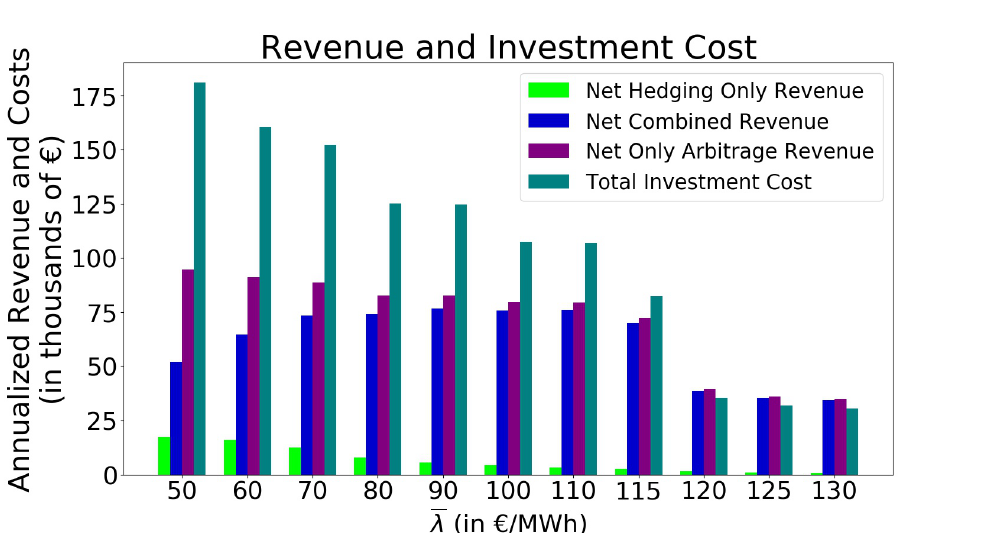
Figure 9. Revenue and investment analysis under different contractual